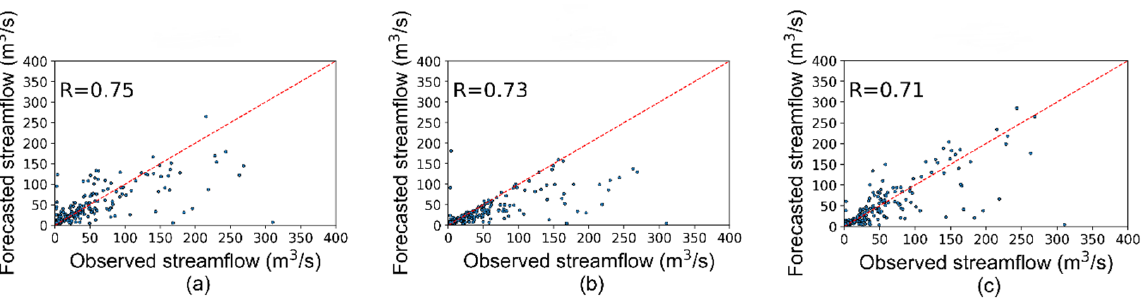
Figure 7. Comparison of forecasting and observed daily streamflow for one-day prediction during the calibration and validation periods using ML models. The blue vertical dashed line divides the time series into calibration and validation periods. A zoom-in of the blue circle area investigates the model’s performance in March 2007.